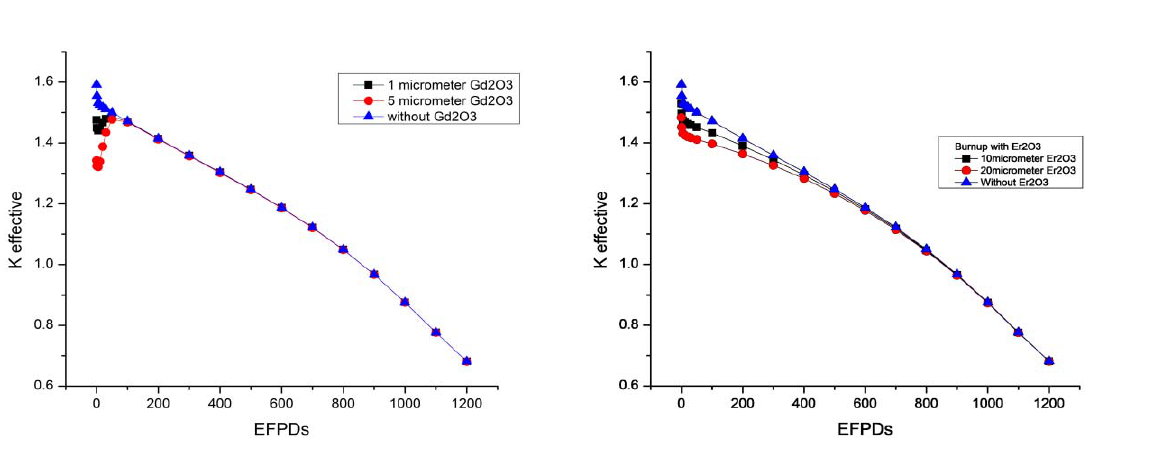
Figure 7. Burnup analysis with burnable